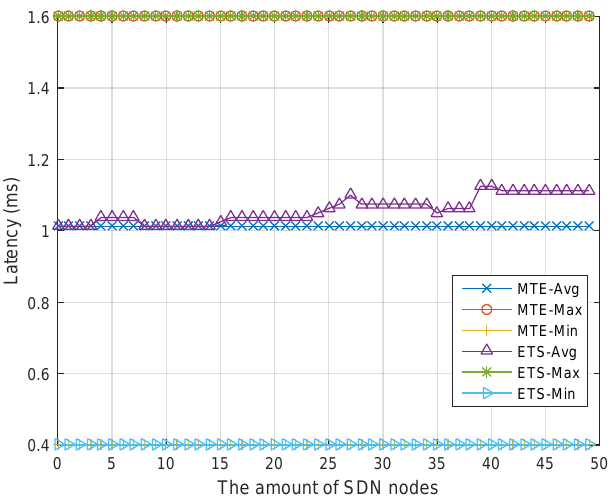
Figure 7. Latency with a different amount of SDN